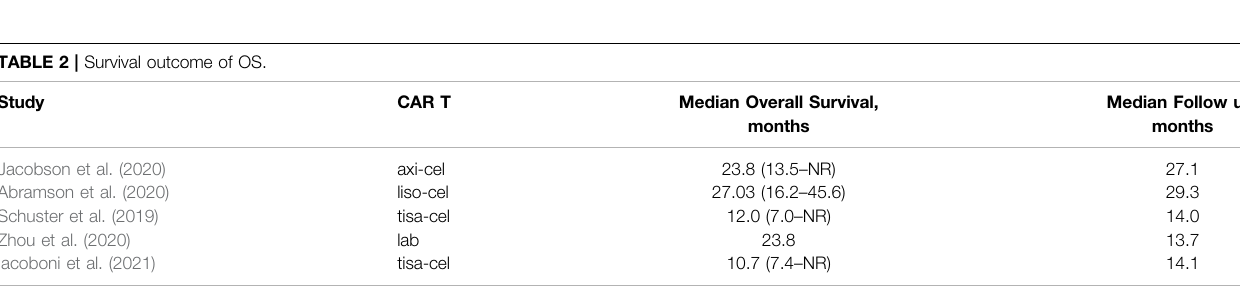
TABLE 2 | Survival outcome of